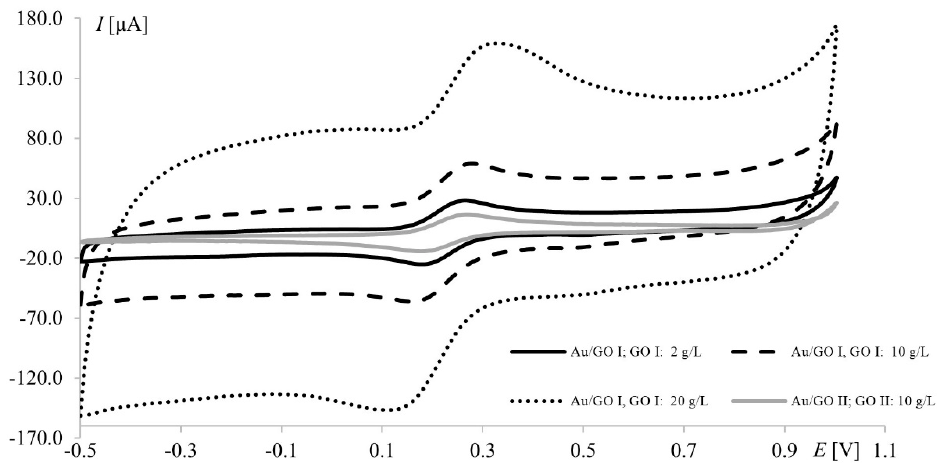
Figure 3. Voltammograms of 1.0 mM Fe(CN) 63 − /Fe(CN) 64 − recorded at the gold electrode modified with graphene oxides I and II; scan rate, 75 mV s − 1 ; supporting electrolyte, 1 M KCl. The model redox pair Fe(CN) 63 − / Fe(CN) 64 − is a chemically reversible system, in which